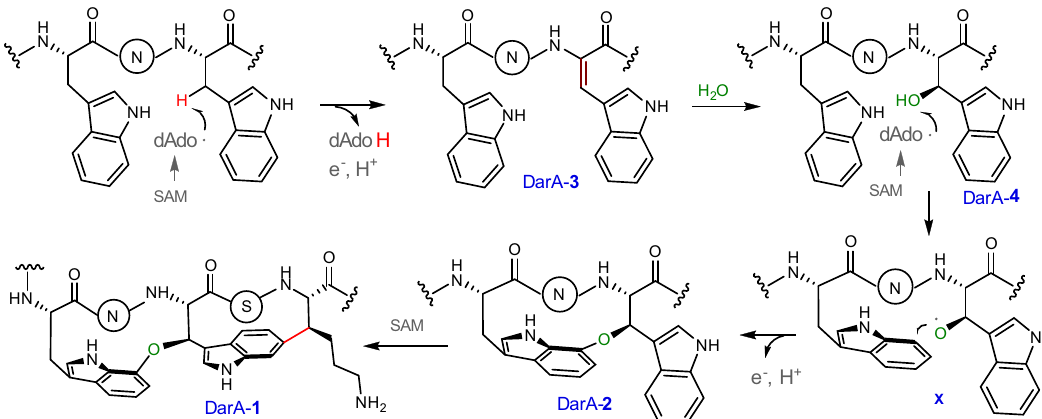
Fig. 4 A proposed mechanism for the DarE-catalyzed bicyclic crosslinking. N in the circle represents the Asn residue between the two Trp residues in DarA (e.g., N 2 in darobactin).